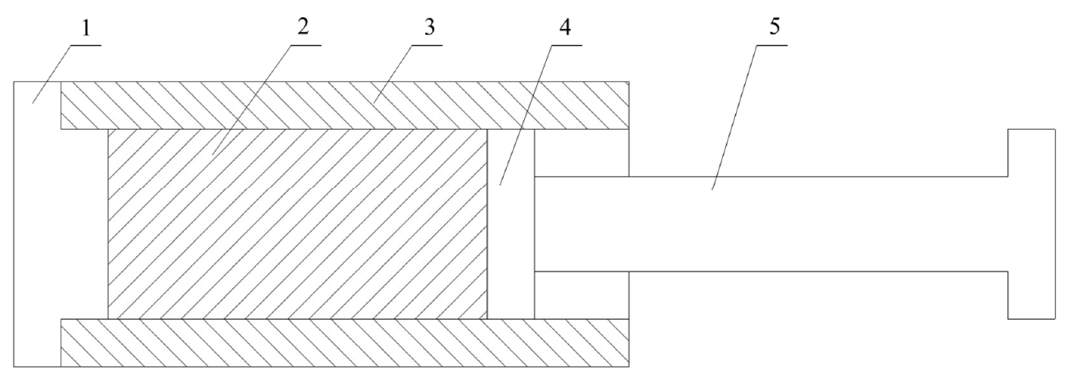
Figure 16. Schematic diagram showing the densification process of blocking hot extrusion. 1: Blocking extrusion die, 2: billet, 3: extrusion cylinder, 4: extrusion pad, and 5: extrusion rod.